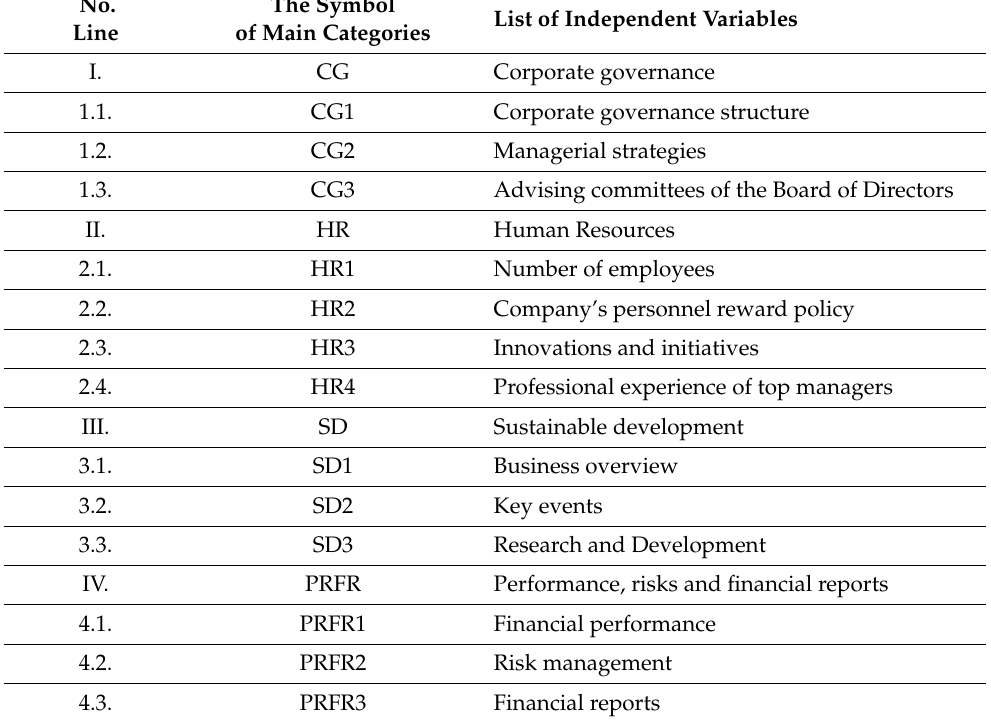
Table 1. The list of variables in the study (latent and observables